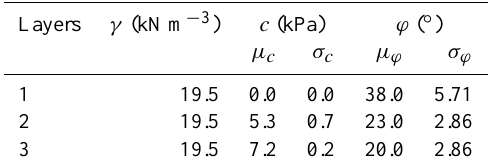
Table 7. Mean values and standard deviations for soil property pa- rameters (soil number from top to bottom). Layers